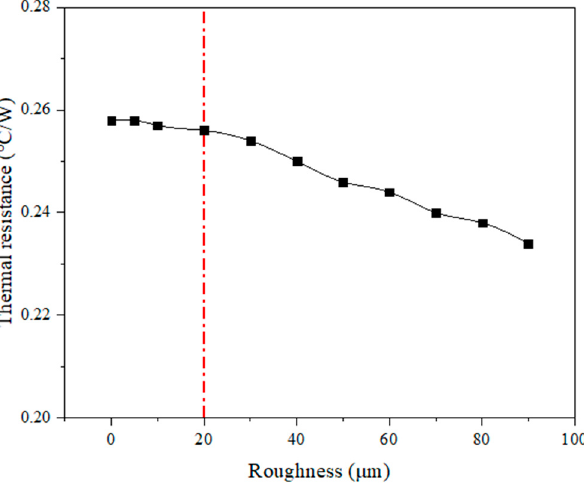
Figure 11. Relationship of thermal resistance versus pipe roughness. According to the above analysis, the optimal design of the three microchannel radiator structures is double-layer backflow, and the optimal parameters are as follows: Hydraulic diameter of the microchannel is 0.5 mm, flow rate of the cooling medium is 24 L/h, inner wall roughness is 0–20 µ m, and the thermal resistance of the chip is 0.256 °C/W. The temperature cloud diagram is shown in Figure